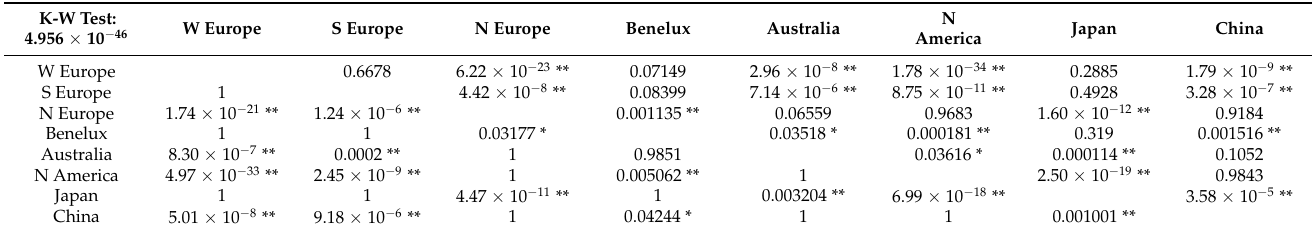
Table 5. Statistical significance of differences between regions, Bonferroni